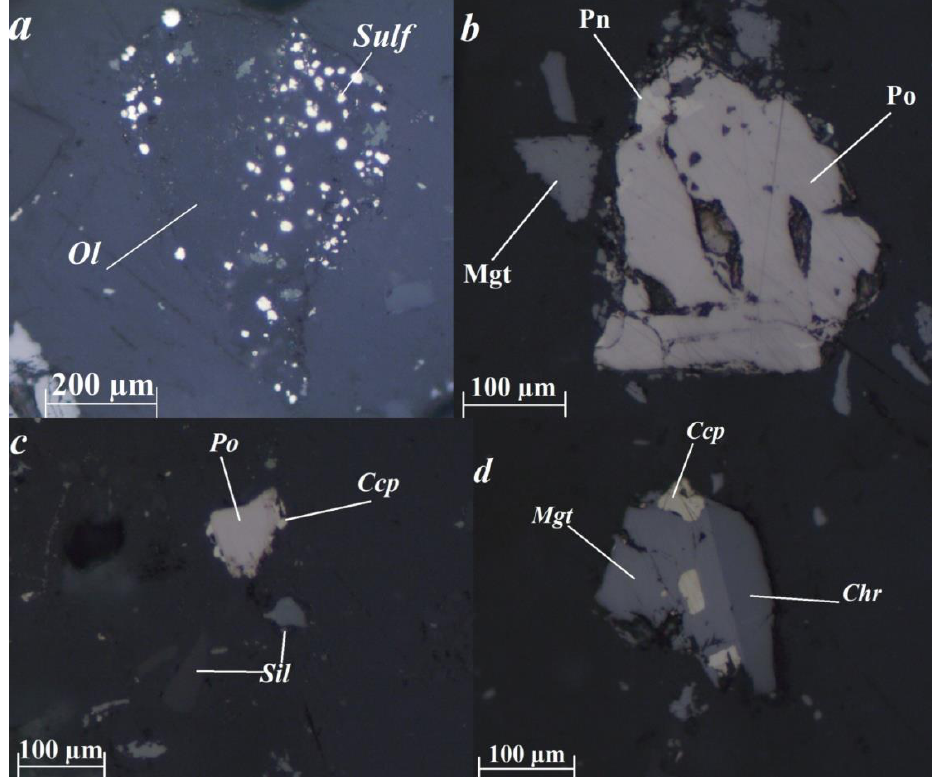
Figure 1. Ore mineral morphology in the tailings. ( a ) — finely-grained sulfide impregnation in olivine; ( b ) — flame-shaped pentlandite ingrowth in pyrrhotite; ( c ) — an intergrowth of pyrrhotite and chalcopyrite; ( d ) — intergrowth of magnetite with inclusions of chalcopyrite and chromite. Image taken in reflected polarized light. Chr — chromite; Ccp — chalcopyrite; Mgt — magnetite; Pn — pentlandite; Po — pyrrhotite; Sil — silicate; Sulf — sulfide.